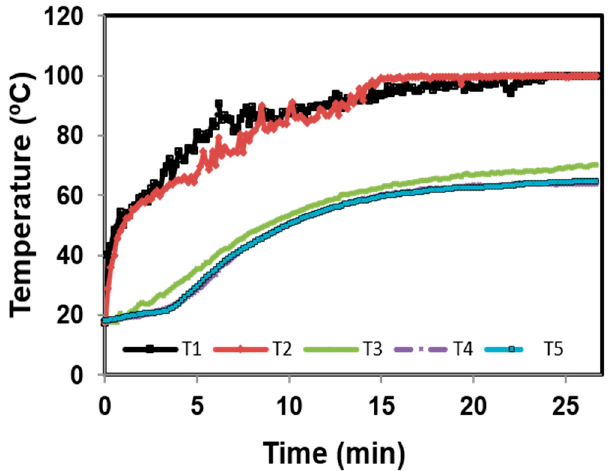
Figure 5. Temperature distribution profile during the Qishta formation: T1: blue circle, T2: red square, T3: green triangle, T4: purple cross, T5: yellow diamond.